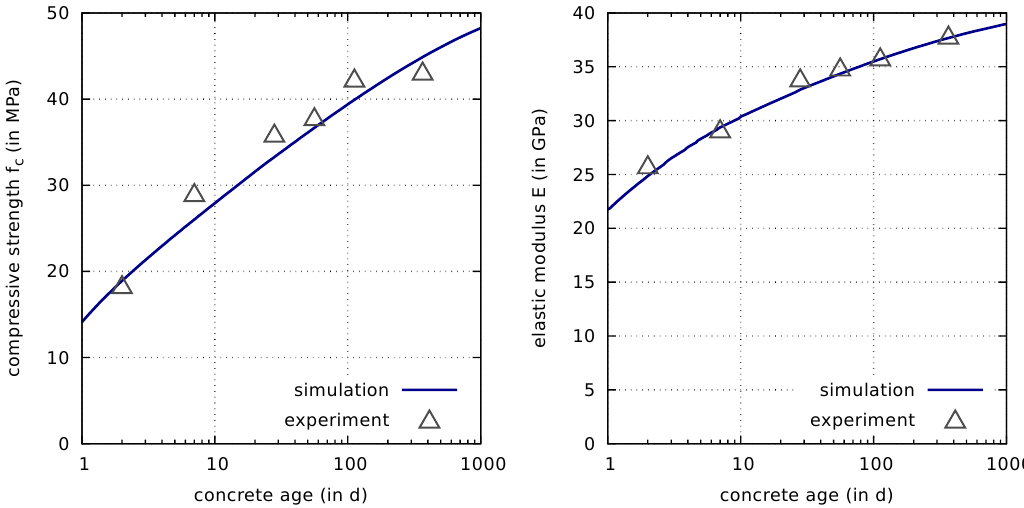
Figure 2. Comparison of computed and measured evolutions of the uniaxial compressive strength ( left ) and the elastic modulus ( right